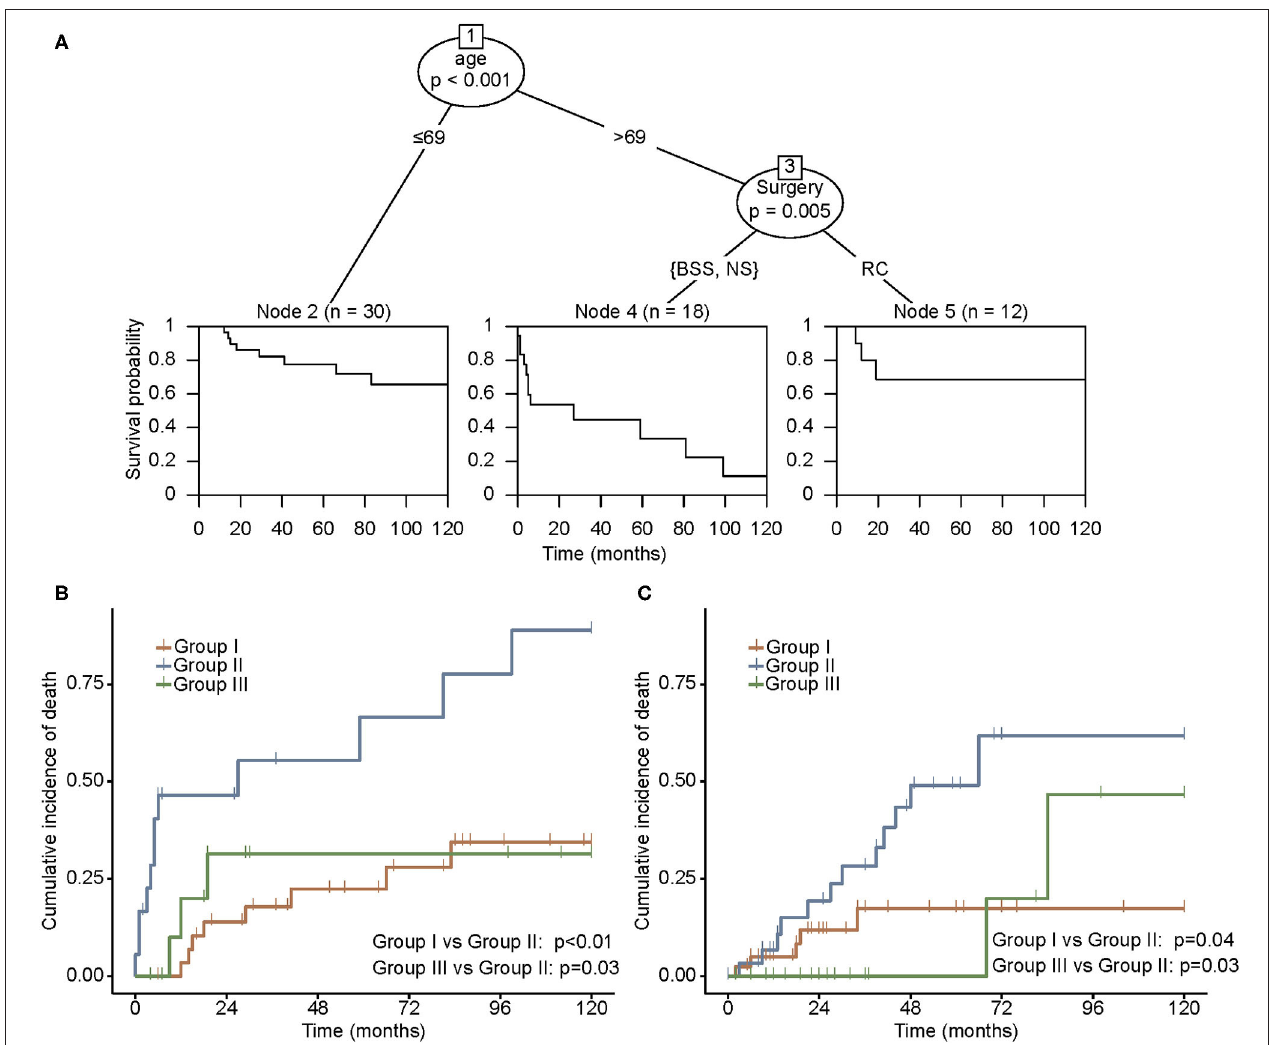
FIGURE 2 | (A) Conditional inference tree (CIT) analysis according to the effect of the nomogram score on OS in the SEER cohort. Cumulative incidence of mortality in the SEER cohort (B) and the LR cohort (C) . Patients were grouped by prognostic classification obtained from CIT. Group I, patients younger than 69 years; group II, patients older than 69 years, receiving BSS or no surgical management; and group III, patients older than 69 years, undergoing RC. BSS, bladder-sparing surgery; LR, literature review; NS, no surgery; OS, overall survival; RC, radical cystectomy; SEER, Surveillance, Epidemiology, and End